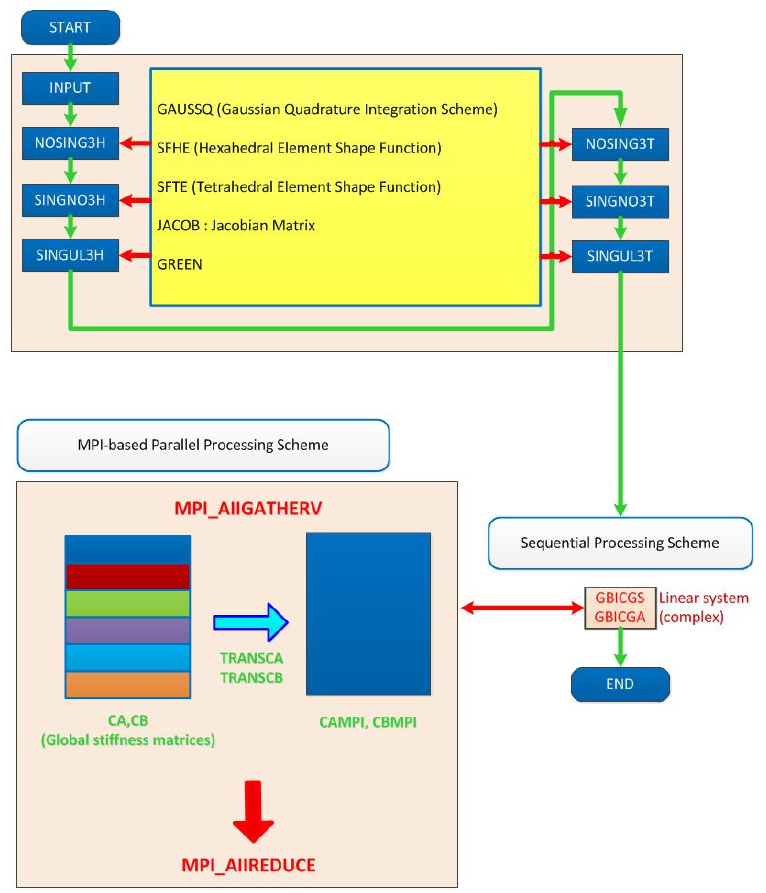
Figure 2. Procedures of ‘pvi3ds01_sm7560xx.f90’ using MPI parallelization.